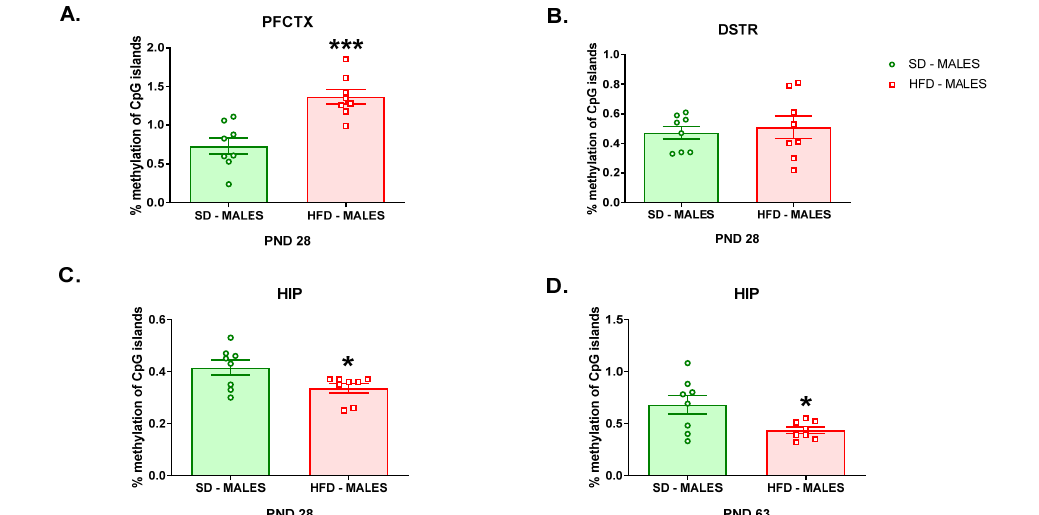
Figure 5. Effects of a maternal HFD during pregnancy and lactation on the methylation of CpG islands at the Cnr1 promoter in the ( A ) PFCTX, ( B ) DSTR, and ( C ) HIP of adolescent offspring and in the ( D ) HIP of young adult offspring. DSTR—dorsal striatum; HFD—high-fat diet; HIP—hippocampus; PFCTX—prefrontal cortex; PND—postnatal day; SD—standard diet. Data are presented as the mean ± SEM with individual value plots. N = 8 rats/group. * p < 0.05; *** p < 0.001 vs. SD.